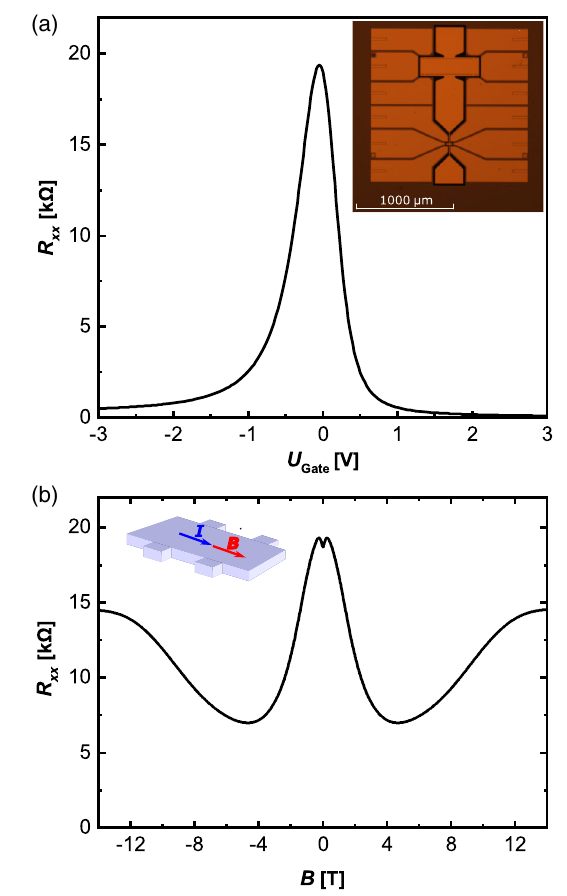
FIG. 3. (a) Longitudinal resistance R xx as a function of the applied gate voltage U for B ¼ 0 . The inset of (a) shows an gate optical microscope picture of the finished sample. (b) R xx as a function of the applied magnetic field B along the current ¼ 0 direction, as indicated by the sketch in the inset, for U gate